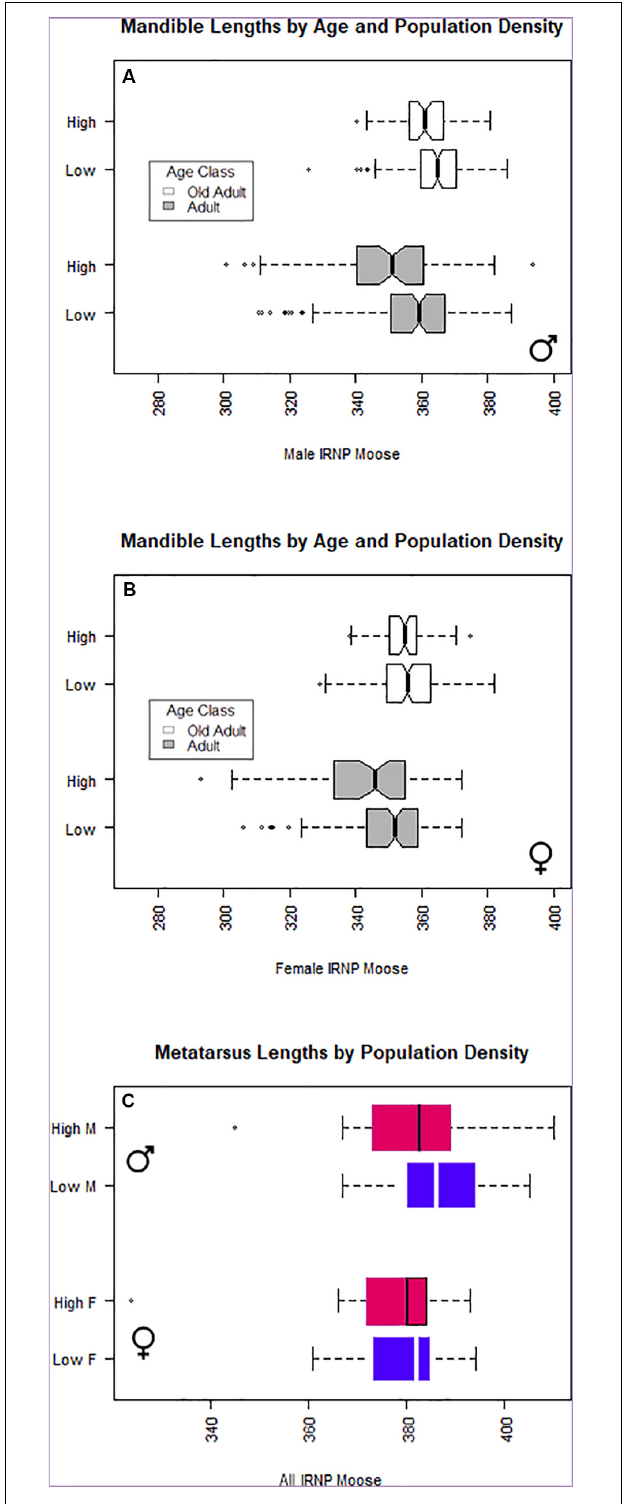
FIGURE 3 | Boxplot of (A) male and (B) female mandible length by age group and population density. (C) Isle Royale moose metatarsus length subdivided by population density and moose sex. Moose reach prime age (sexual maturity) before skeletal growth